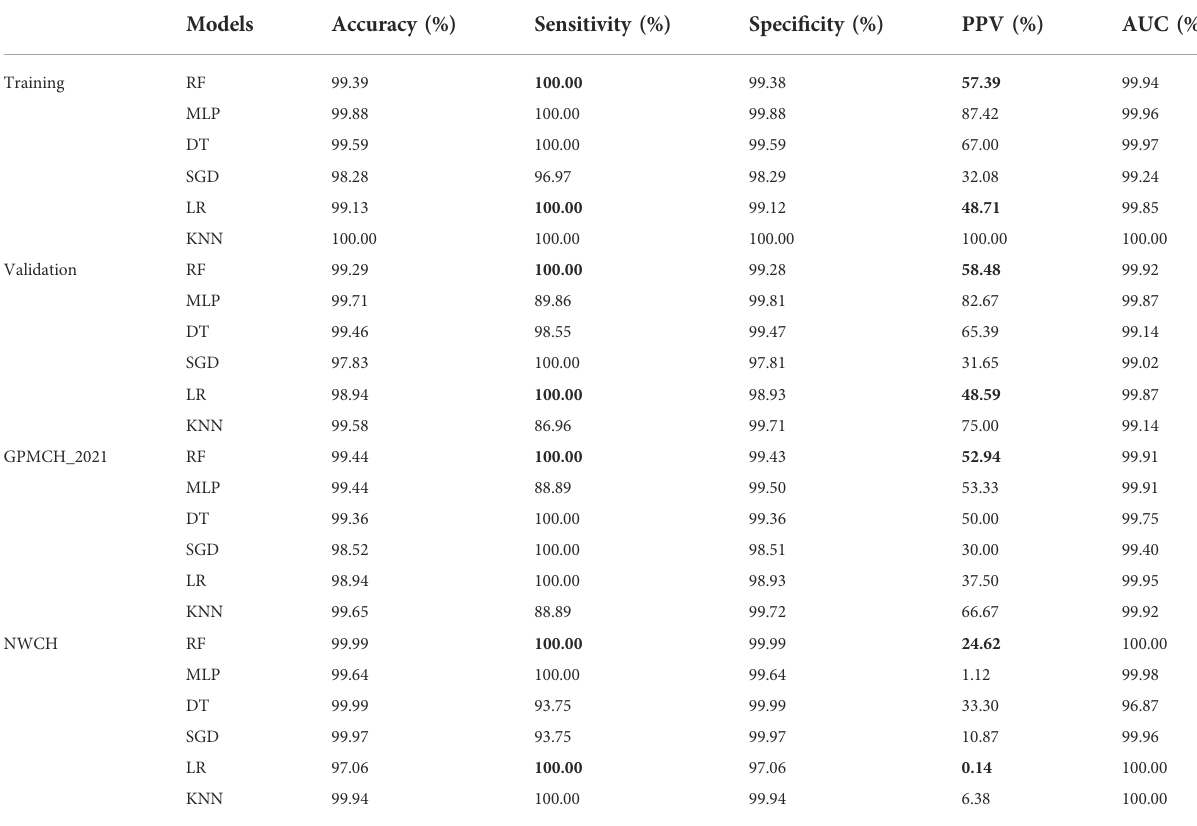
TABLE 2 Results of multi-classi fi cation models of PKU. And, the bold values represent better results than other